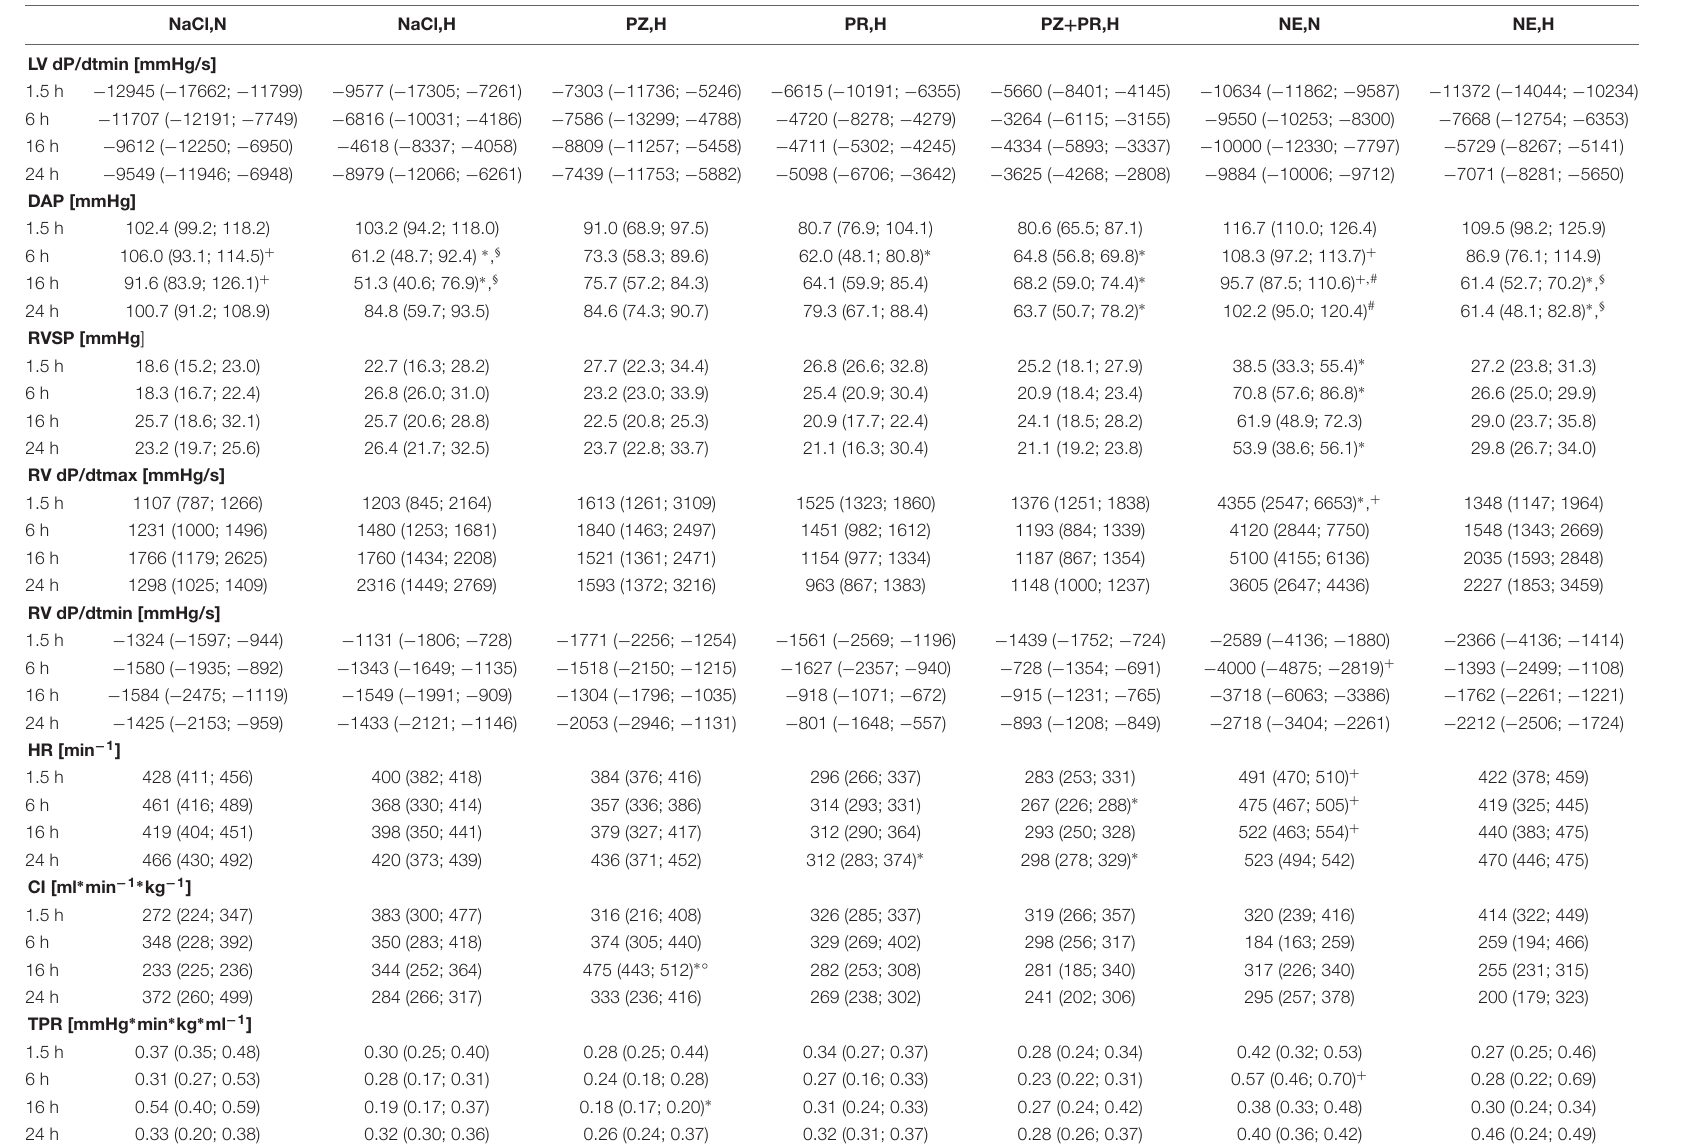
TABLE 2 | Effects of hypoxia and/or adrenergic and antiadrenergic treatment on hemodynamic